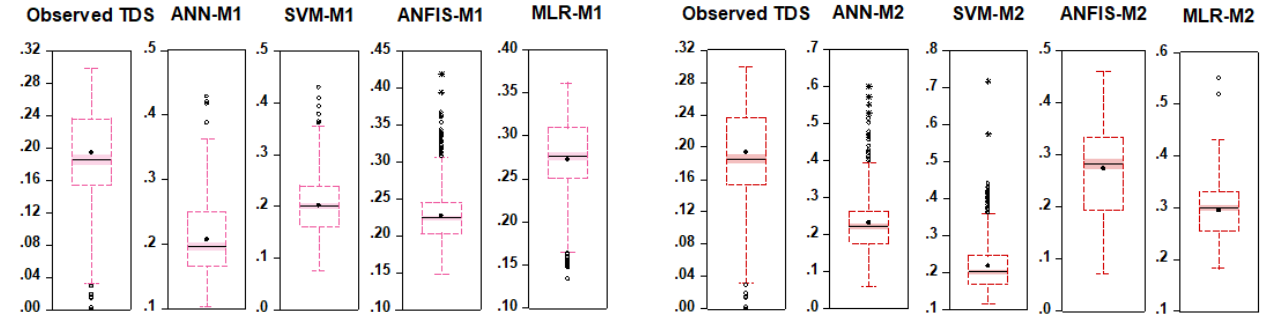
10 of 18 Figure 7. Radar chart for ( a ) goodness-of-fit and ( b ) correlation coefficient for TDS. Furthermore, a radar plot was used to compare the predictive accuracy of the models. As mentioned earlier, radar plots are important in depicting the performance comparison of the models due to their transparency. In this vein, a radar chart is a type of graph used to compare three or more variables on a two-dimensional plane. Radar charts can easily be used for depicting several variables without creating a clutter and they are viewed as a better substitute for column graphs. Thus, radar plots were used regarding R and R 2 for the training and validation phases. According to Figure 8, it was observed that the R-val- ues in the training and validation phases were ANN-M1 = 0.9977, ANN-M2 = 0.9814, SVM- M1 = 0.9993, SVM-M2 = 0.9925, ANFIS-M1 = 0.9857, ANFIS-M2 = 0.9115, MLR-M1 = 0.9138,